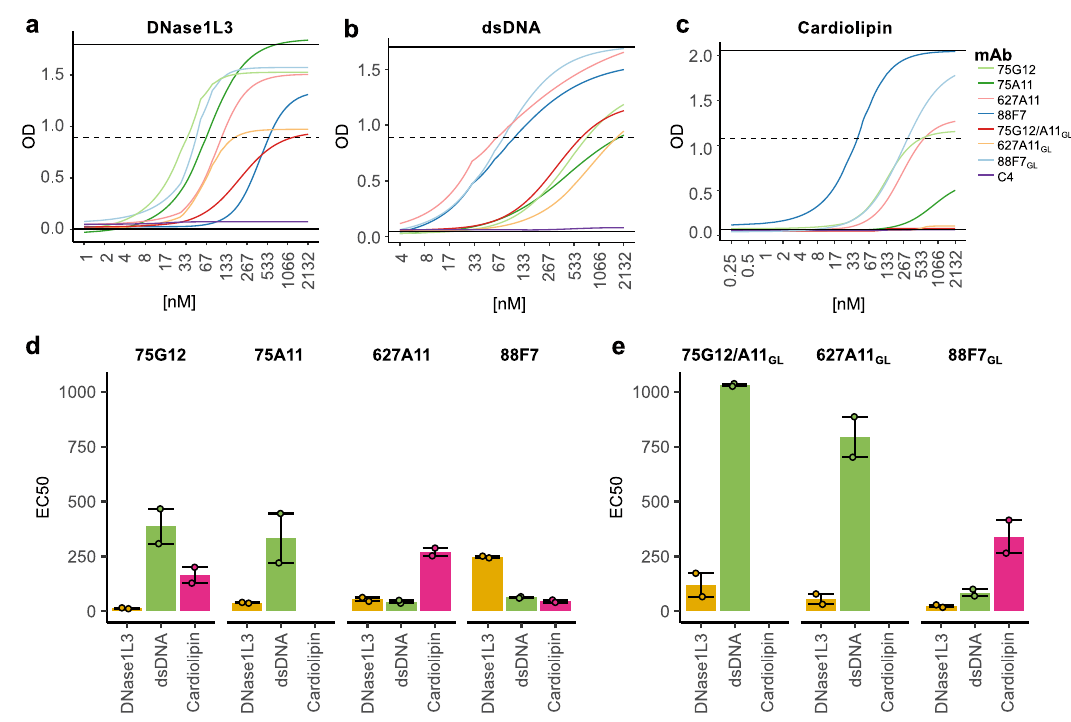
Fig. 5 | Half-maximal effective concentration (EC 50 ) for V H 4-34 anti-DNase1L3 monoclonal antibody binding to DNase1L3, dsDNA and cardiolipin. a – c Monoclonal anti-DNase1L3 antibodies and their germline (GL) variants were titrated against DNase1L3 ( a ), dsDNA ( b ) and cardiolipin ( c ). Curves on the graph correspond to the fi ttedfour-parameter logistic (4PL) model used to calculate the